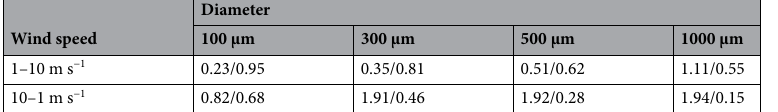
Table 3. Median value and standard deviation of the final position of Microcystis colonies under varying wind speeds. Median value/standard deviation (unit: m).